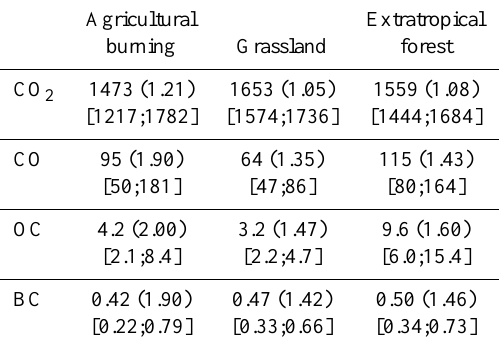
Table 1. Biomass burning emission factors ( β , gkg − 1 ) used in Eq. (1), their geometric standard deviation ( σ g , given in the round brackets), and the respective uncertainty range (given in the square brackets in terms of 1- σ g interval) for different types of vegetative land cover. The data are based on Andreae and Merlet (2001) and subsequent